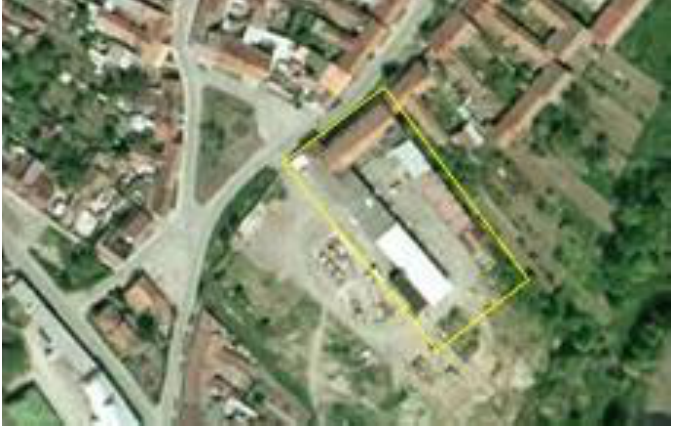
Figure 5. A view of the social care home for elderly people from the courtyard in Vranovice. Source: K. Charvátová (2021).